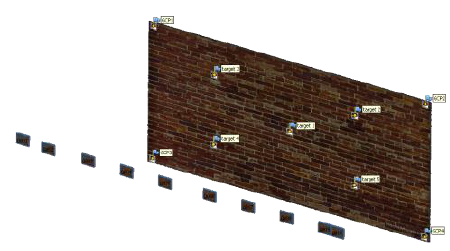
Figure 9 Distribution of GCPs and checkpoints and the initial minimal camera network